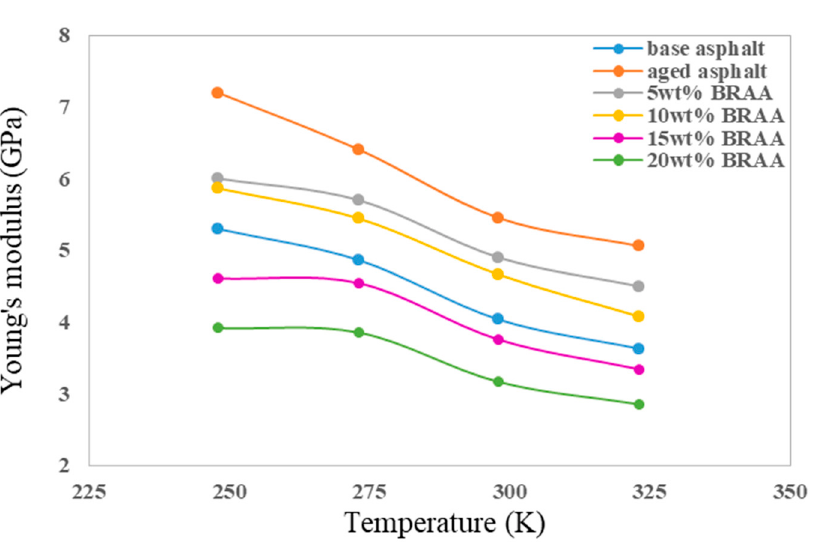
Figure 7. Young’s moduli of asphalt systems at different temperatures.